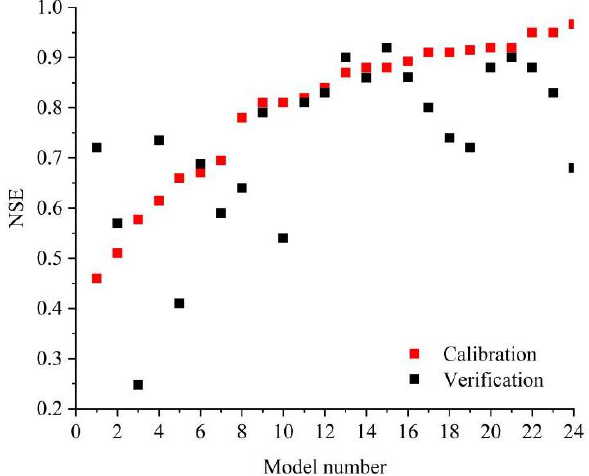
Figure 5. Comparison of model accuracy during calibration and verification.